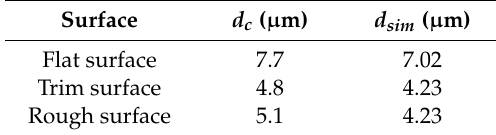
Table 8. Validation of results in terms of crater